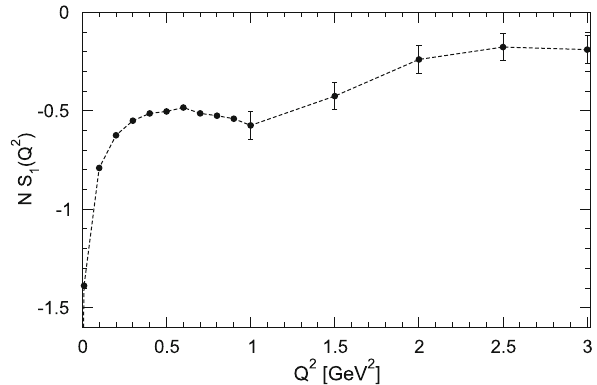
( Q 2 ) in units of GeV − 2 , for 0 ≤ Q 2 ≤ 3, where 1 ) 2 , with M 2 = 0 . 71GeV d d